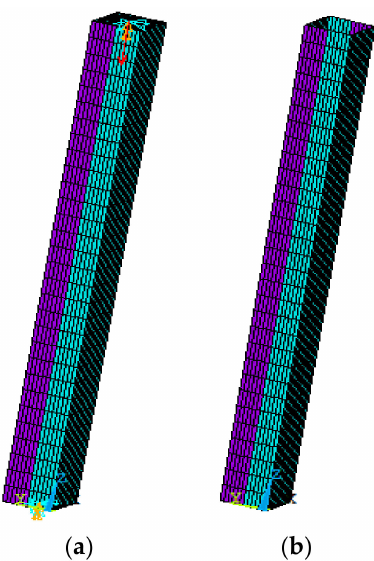
Figure 11. Basic finite element model. ( a )with constraint, ( b ) without constraint